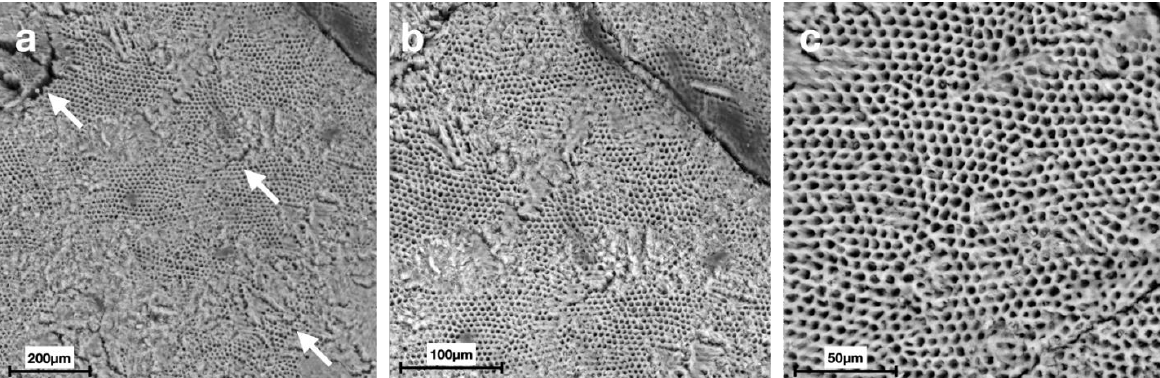
Figure 3. Scanning electron micrographs of G5 (group treated with the demineralizing solution): ( a ) an irregular surface with the presence of cracks and an early stage of destruction of the interpris- matic substance (white arrows) at 200× magnification; ( b , c ) the “honeycomb structure” character- ized by the selective dissolution of the apatite crystals inside the prisms, typical of the enamel de- mineralization morphology, at 500× and 1000× magnification, respectively.